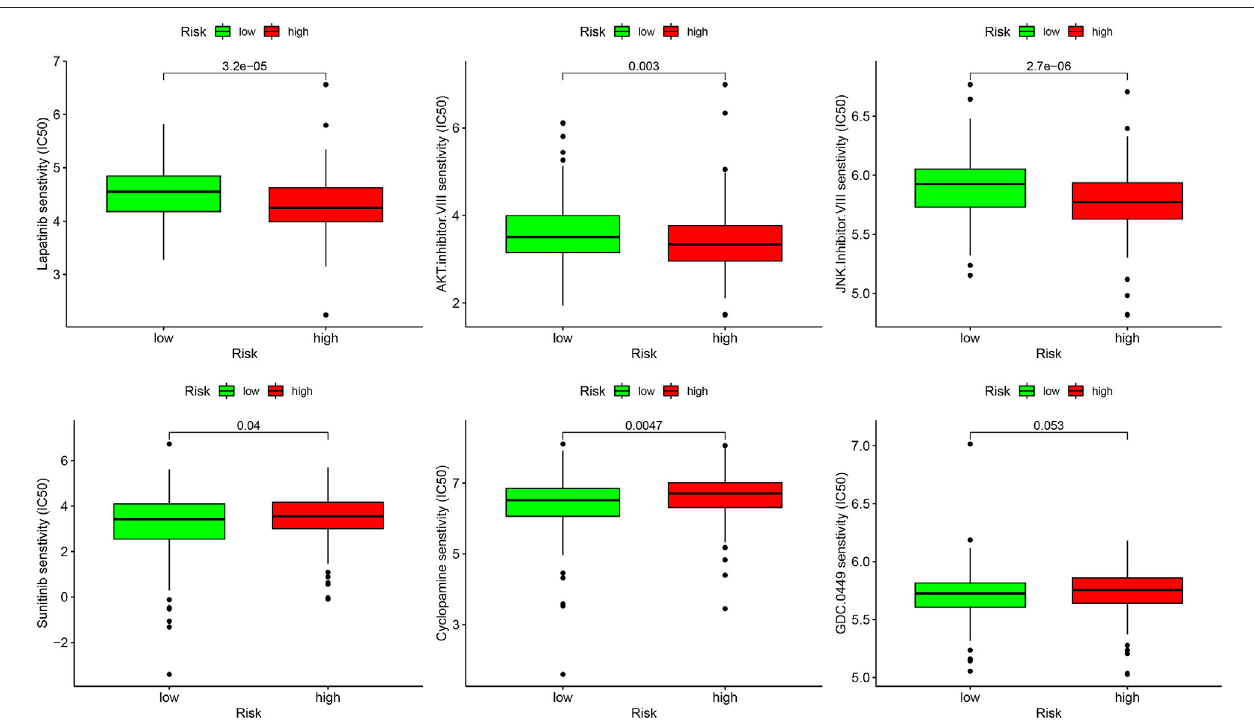
FIGURE 9 | The sensitivity difference of multiple targeted inhibitors within different risk groups.